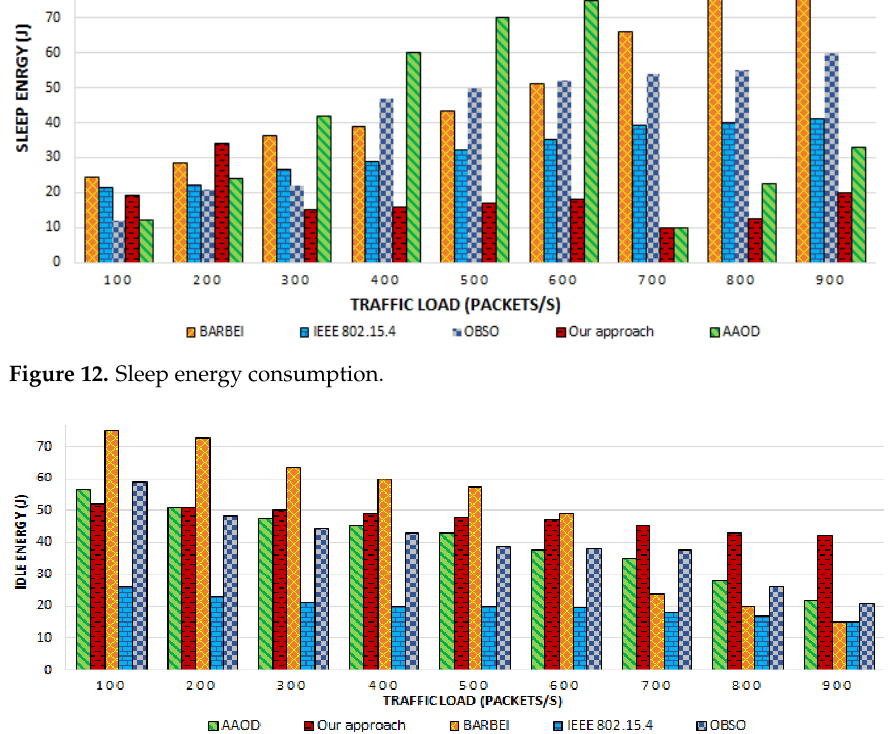
Figure 12. Sleep energy consumption.